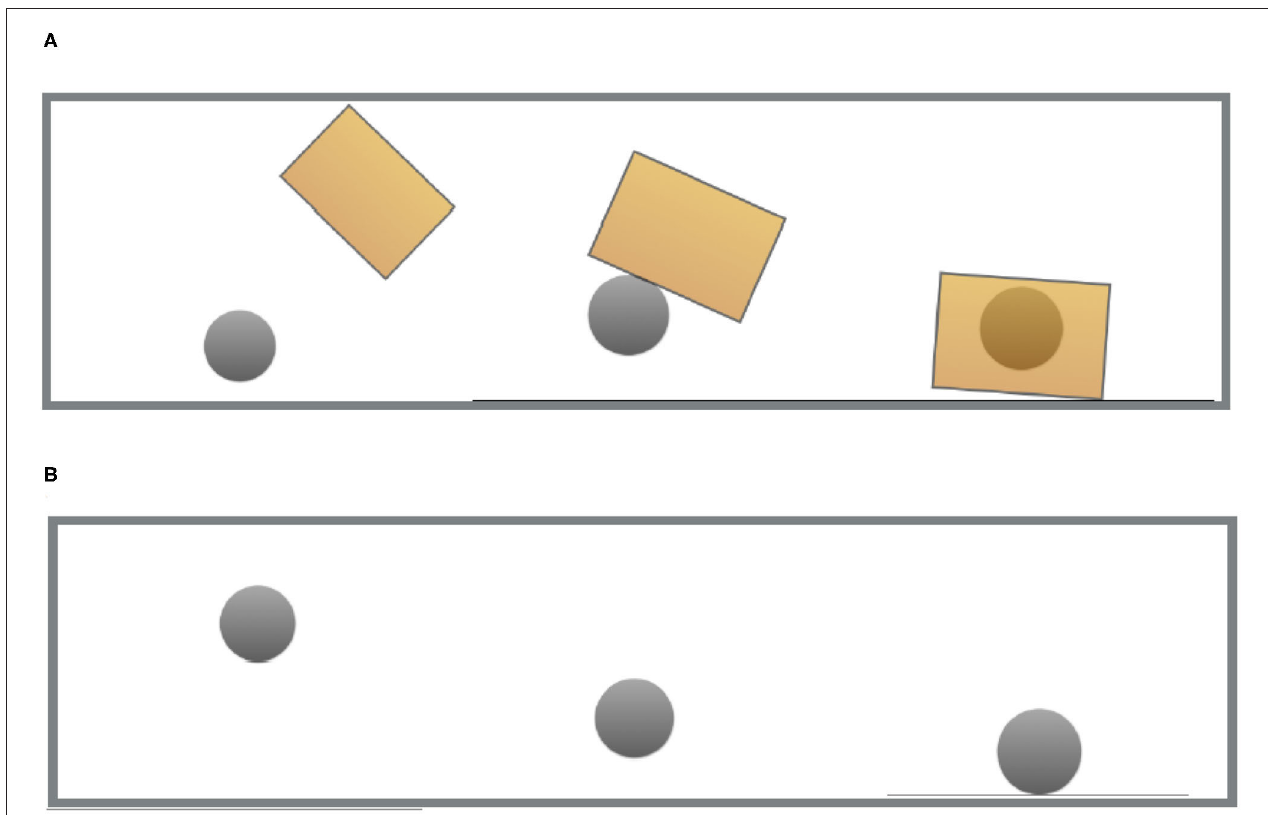
FIGURE 1 | Stills from the video used in the “match” and “mismatch” conditions of experiments 1–4. (A) Visual prime—Containment. (B) Visual prime—Non-containment.